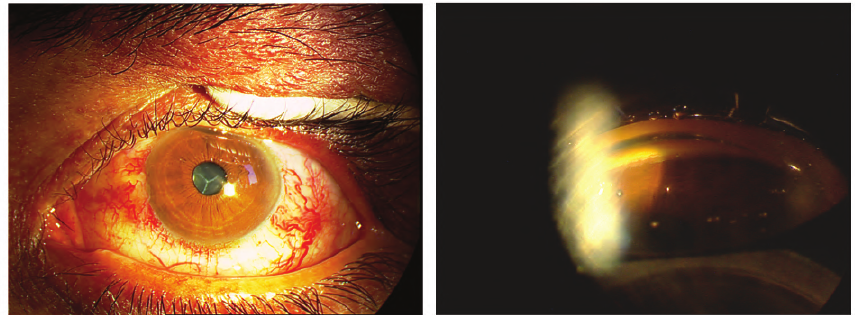
Figure 1. Left image shows conjunctival and episcleral abnormal tortuous vessels in a patient with Sturge-Weber syndrome. Presence of blood in the Schlemm’s canal in gonioscopy of the same patient.